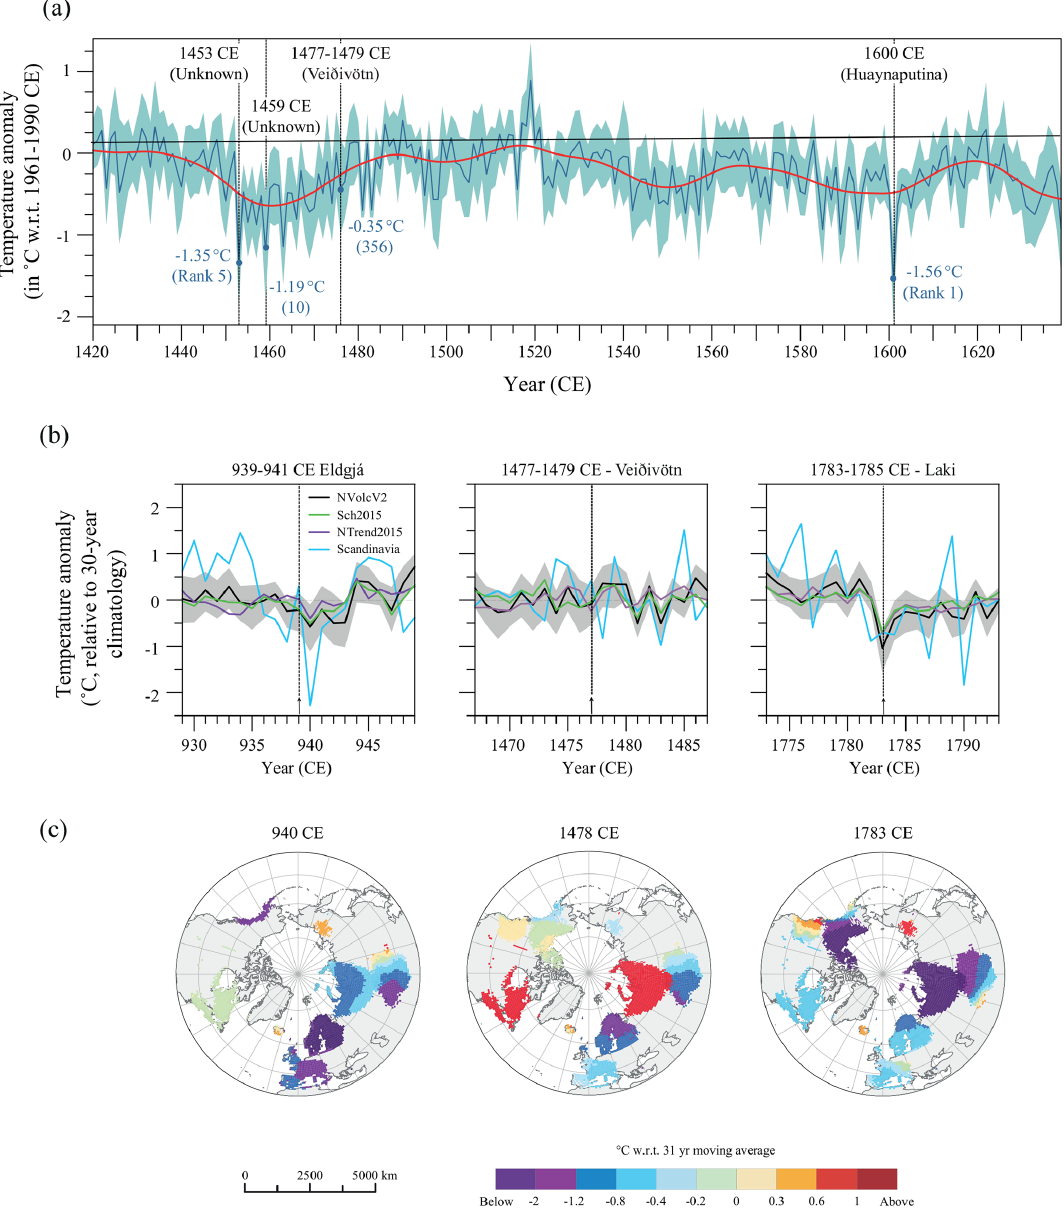
Figure 6. (a) Northern hemispheric (40–90 ◦ N) summer (JJA) temperature reconstruction depicting the cooling induced by selected 15th to 17th century volcanic eruptions. The red line depicts 30-year smoothed temperatures, whereas the blue line indicates annual temperature anomalies. The blue shaded area gives the 95% confidence interval. (b) Cooling induced by the most prominent Icelandic eruptions of the last 1500 years in 939CE (Eldgjá), 1477CE (Veiðivötn) and 1783CE (Laki) in the NVOLC v2 (Guillet et al., 2020), Sch2015 (Schneider et al., 2015), NTREND2015 (Wilson et al., 2016) and Scandinavian cluster of NVOLC v2. (c) Spatial patterns of Northern Hemisphere temperatures the year following the three major Icelandic eruptions in the last 1500